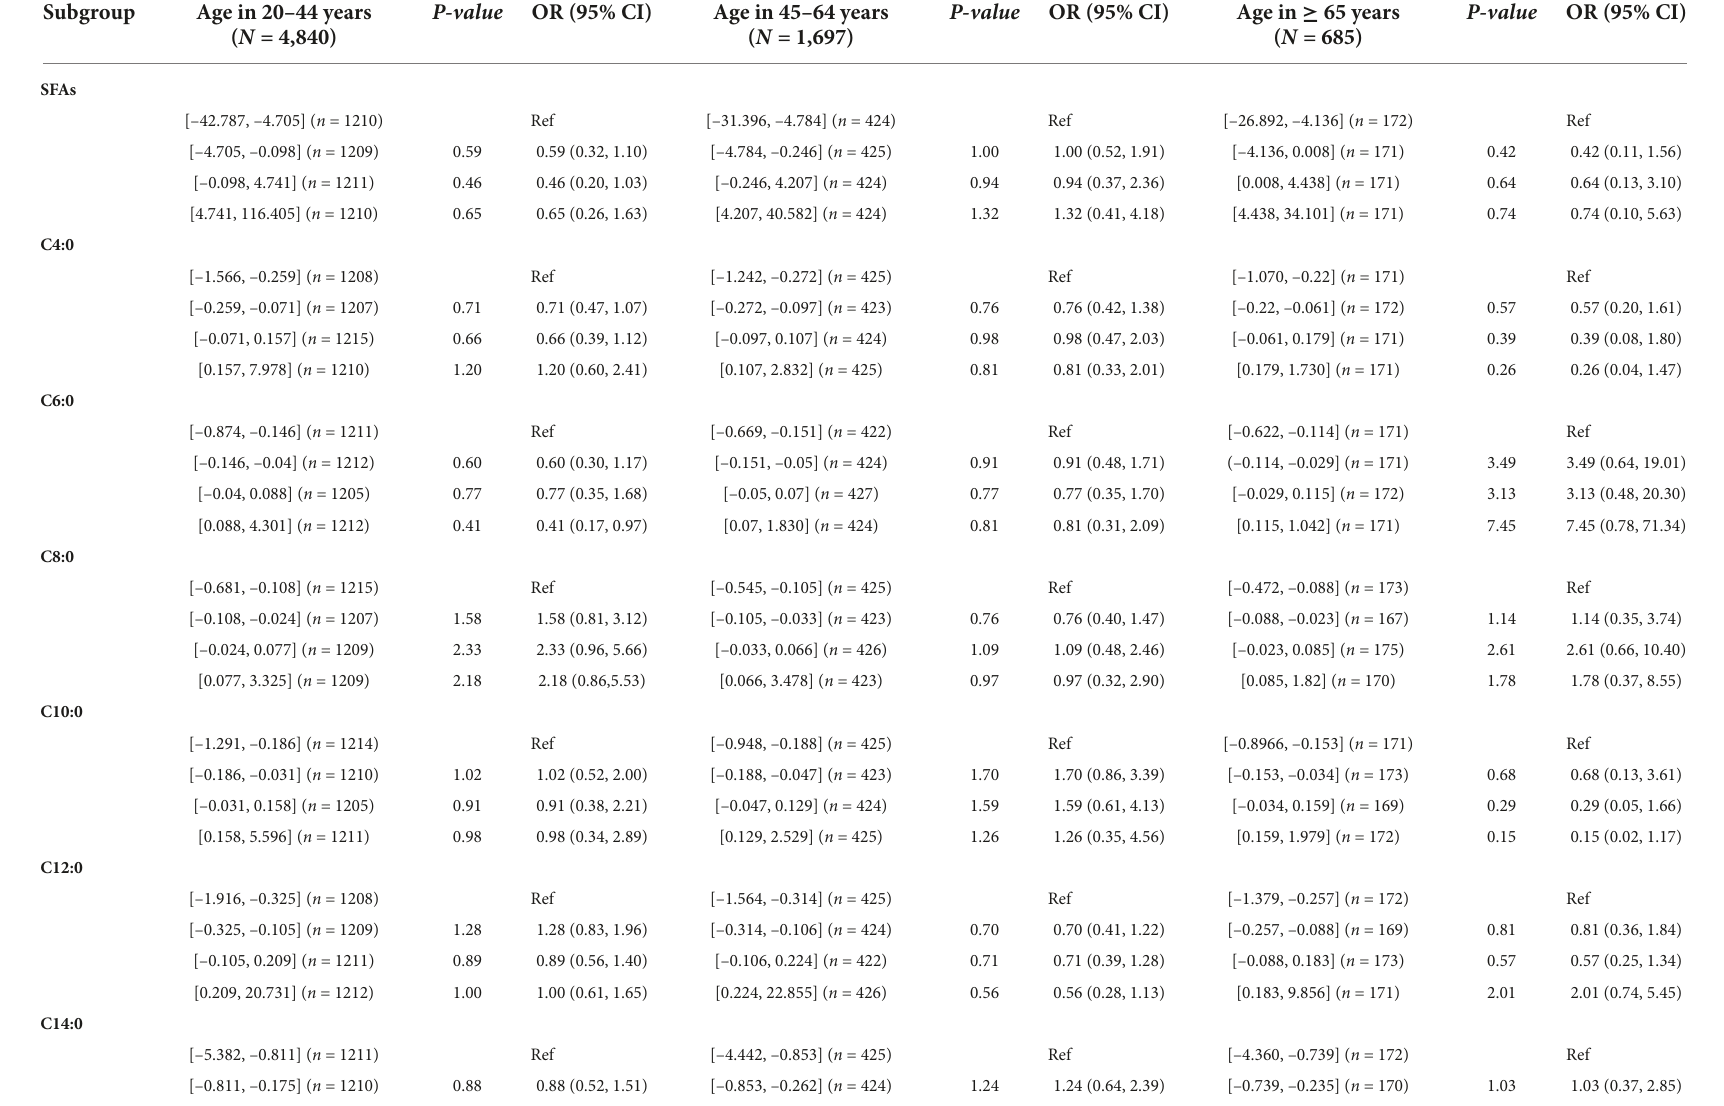
TABLE 7 Weighted OR (95% CI) for hypertension in quartiles of adjusted dietary saturated fatty acid intake stratified by age in NHANES, 1999–2018.